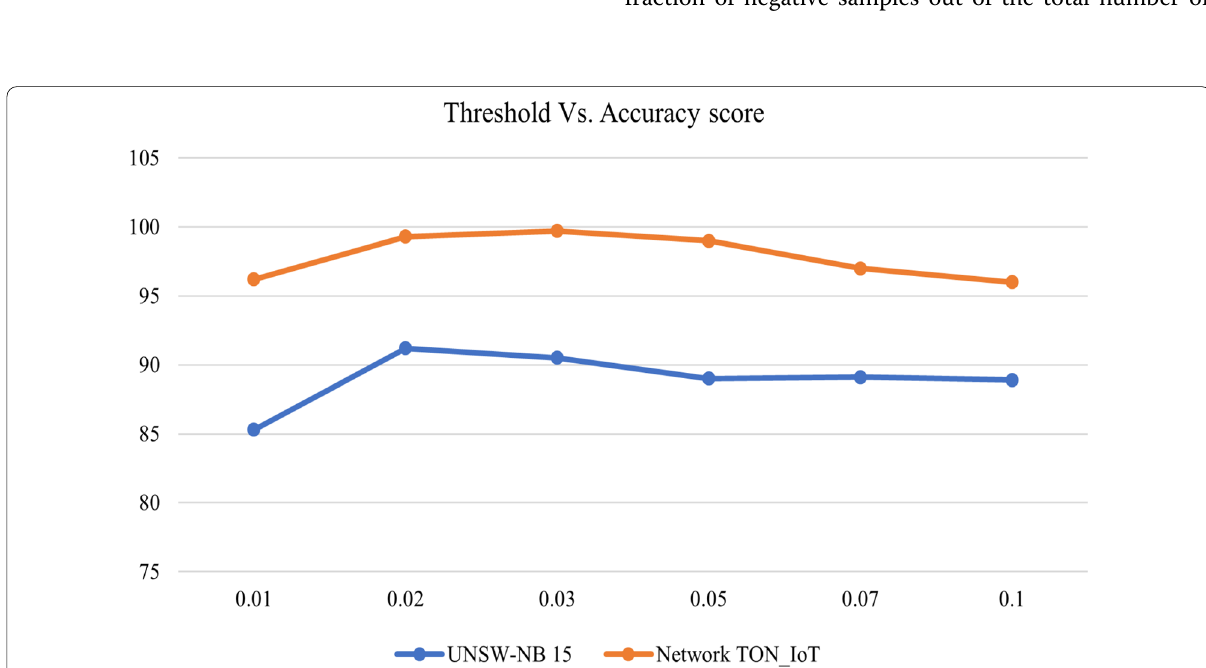
Fig. 8 Accuracy versus threshold value for UNSW-NB 15 and Network TON_IoT dataset